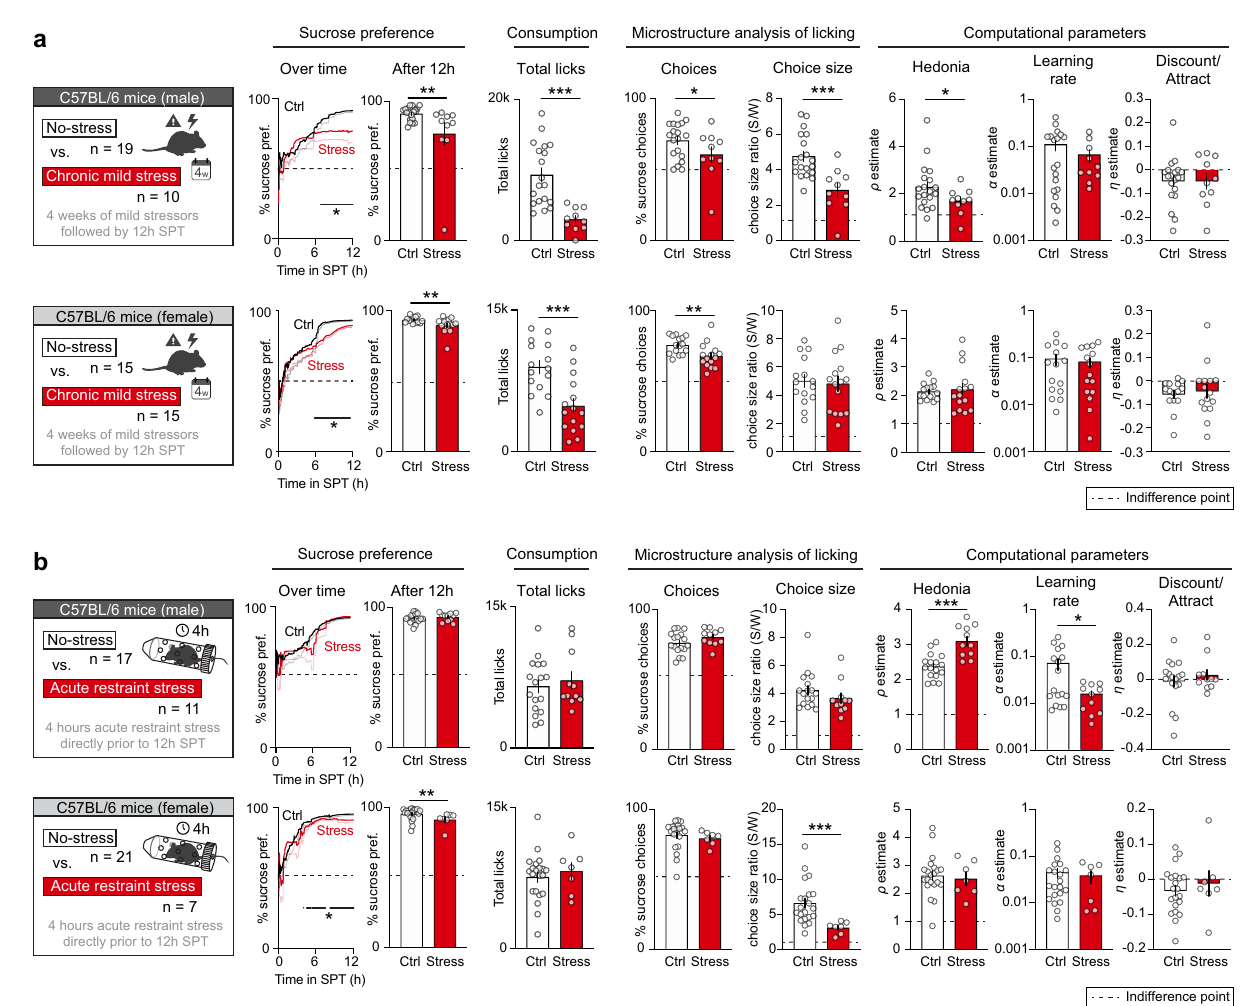
Fig. 3 | Different outcome measures following chronic and acute stress. a Behavior in the SPT after 4 weeks ofchronic mild stress in male (top)and female (bottom)C57Bl/6mice.Stressedanimalsshowedareductioninsucrosepreference and total liquid consumption. A micro-structural analysis of licking behavior fol- lowed by computational model fi tting indicated sex-dependent changes to the component processes subserving sucrose preference. b Behavior in the SPT after 4h ofacute restraint stress inmale (top)and female (bottom) C57Bl/6mice. Acute stress induced a sucrose preference de fi cit through a reduction in the choice size ratio, but only in female mice. Two different control (ctrl) groups were used to